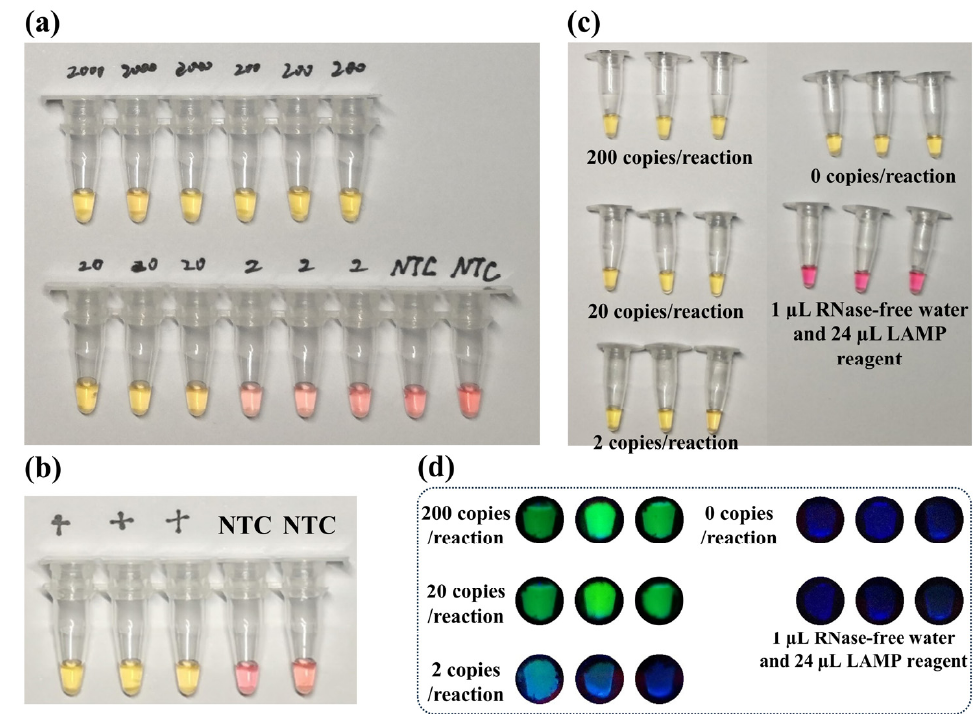
Figure 4. ( a ) Results of colorimetric RT-LAMP for different concentrations of SARS-CoV-2. ( b ) Results of colorimetric RT-LAMP for MS2 phage. ( c ) Results of dual colorimetric RT-LAMP for SARS-CoV-2 and MS2 phage. ( d ) Fluorescence visualized results of CRISPR reaction.